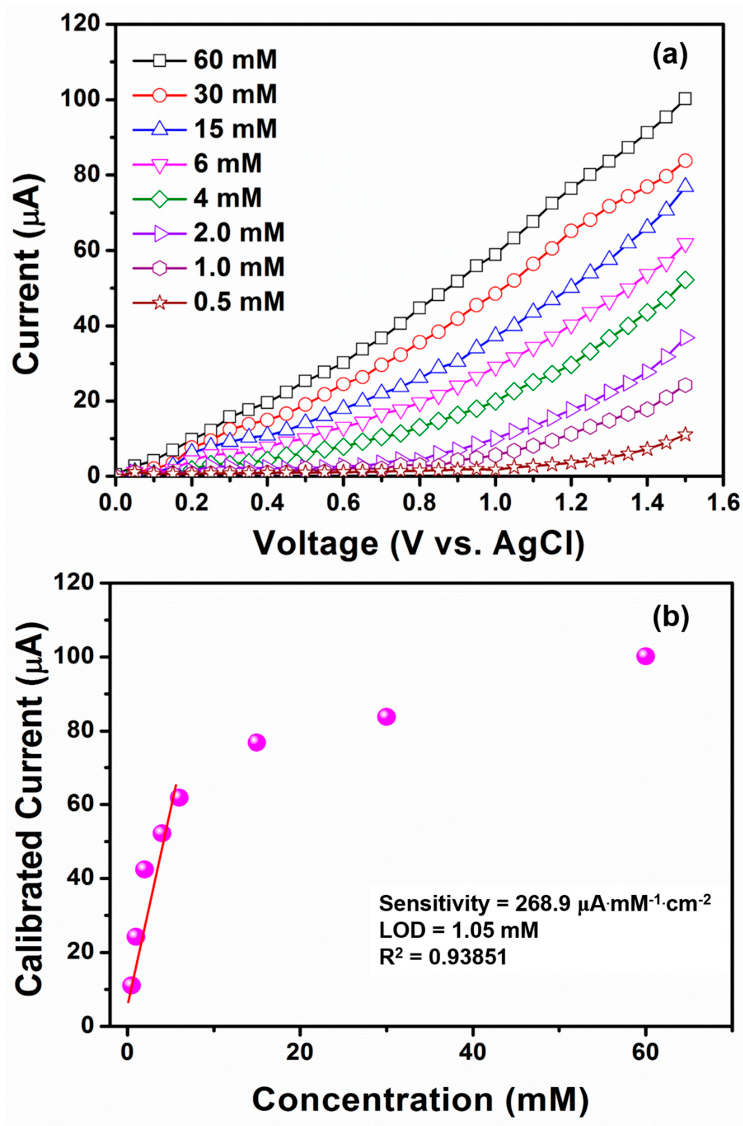
Figure 8. Typical ( a ) concentration-dependent (concentrations of 60–0.5 mM in 0.1 M PBS) I–V response of the fabricated TiO 2 nanoflowers-based nitroaniline chemical sensor; ( b ) corresponding graph for calibration current vs. concentration of nitroaniline.